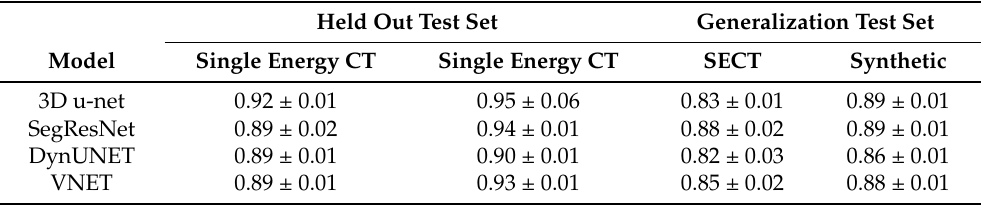
Table 2. Dice scores from the 5-fold cross validation and the nine test cases from the CT-ORG generalization dataset.